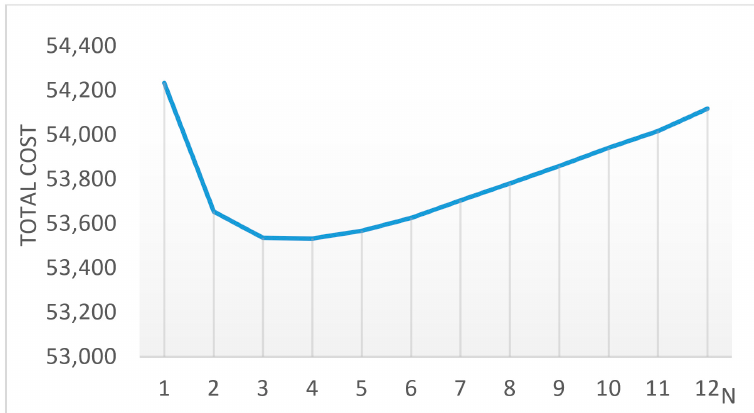
Figure 6. Optimal number of preventive maintenance actions.